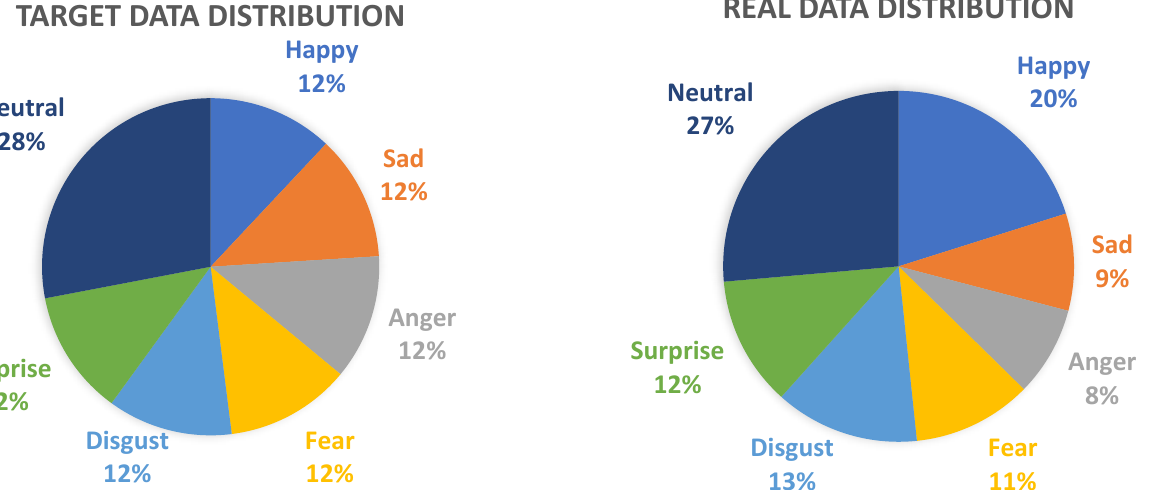
Figure 5. Maxim PPG Band.